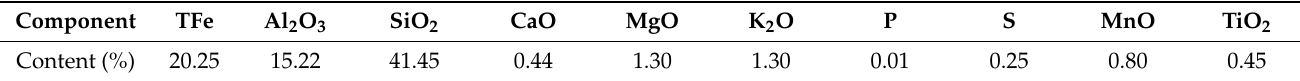
Table 1. The results of chemical multi-element analysis of the discarded iron tailings.